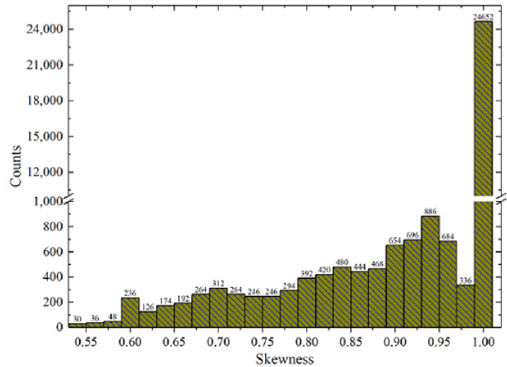
Figure 7. Mesh quality histogram.